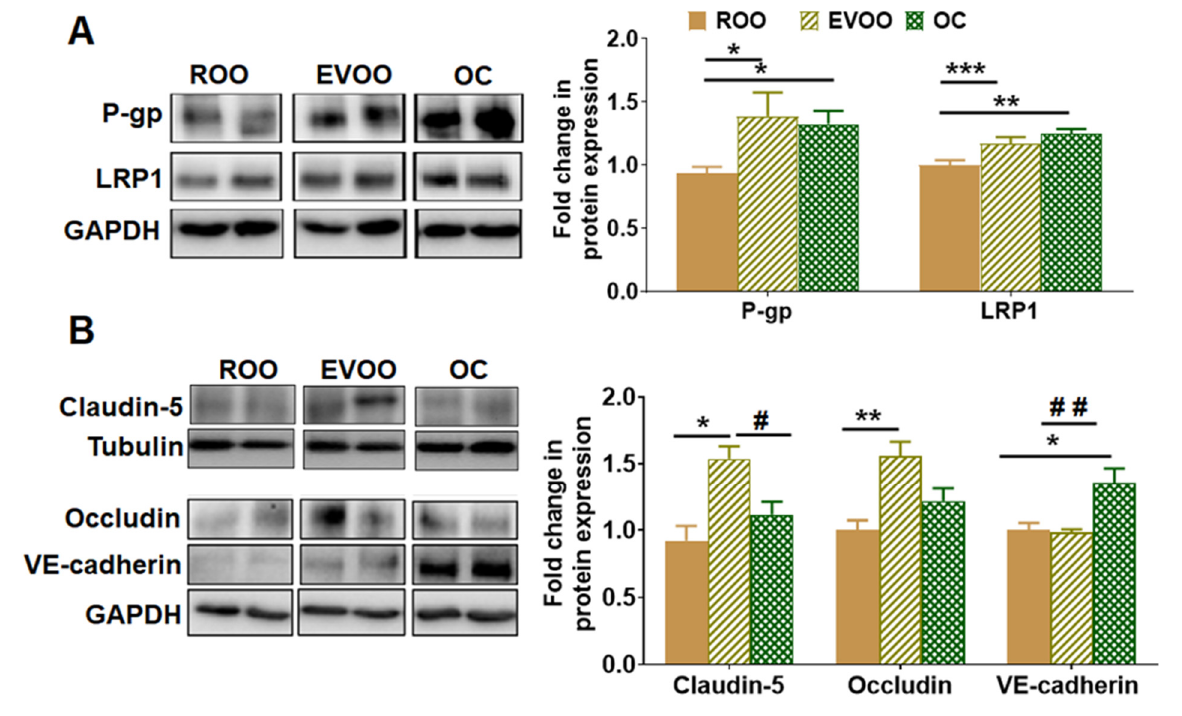
Figure 2. Effect of EVOO and OC consumption (0.5 μ g/kg) for three months on A β clearance, and tight and adherence junction proteins in 5xFAD mouse brains. ( A ) Representative blots and densitometry analysis of A β major transport proteins across the BBB, P ‐ gp, and LRP1. ( B ) Representative blots and densitometry analysis of the tight junction proteins claudin ‐ 5 and occludin and the adherence protein VE ‐ cadherin (n = 6–8 mice per group). Values were normalized to the ROO group (1.0). Data are presented as mean ± SEM. * p < 0.05, ** p < 0.01, *** p < 0.001 compared to ROO; and # p < 0.05, ## p < 0.01 compared to EVOO.